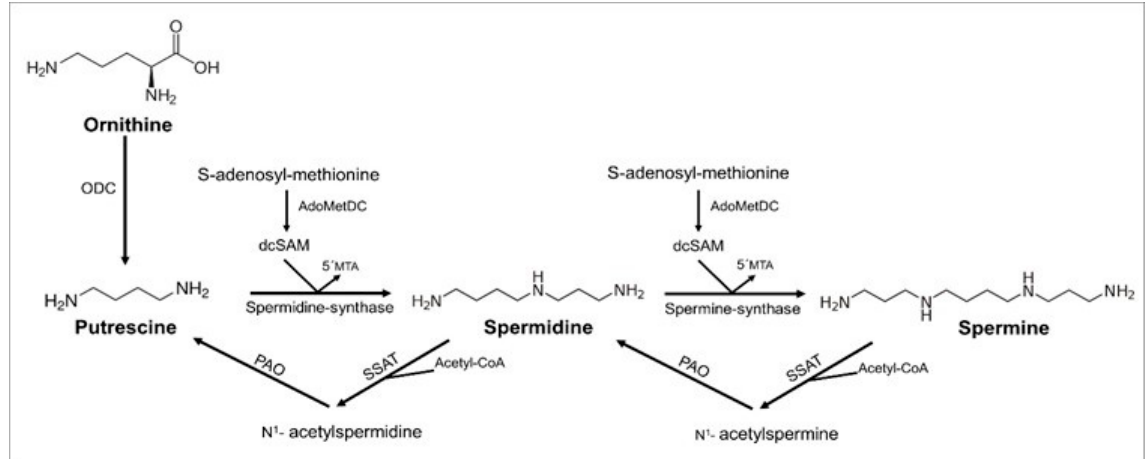
Figure 1. Synthesis and interconversion of polyamines. ODC: ornithine-decarboxylase; AdoMetDC: S-adenosyl-L-methionine-decarboxylase; dcSAM: decarboxylated S-adenosyl-methionine; 5’MTA: 5 ′ -methylthioadenosine; SSAT: spermidine/spermine N1-acetyl-transferase; Acetyl-CoA: acetyl coenzyme-A; PAO: polyamine-oxidase. Adapted from Muñoz-Esparza et al. [15].